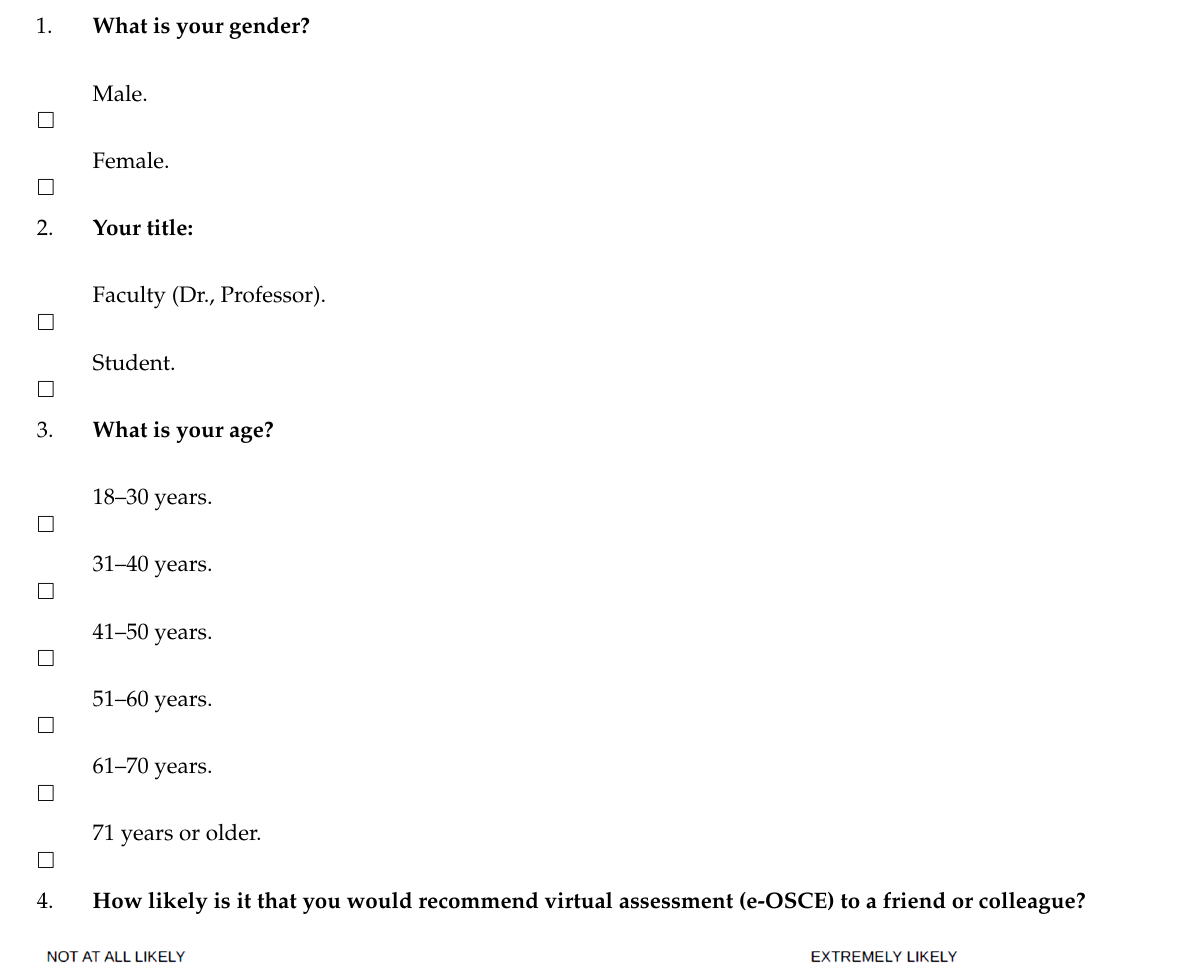
Table A1. Questionnaire on faculty’s and students’ perceptions of the pediatric